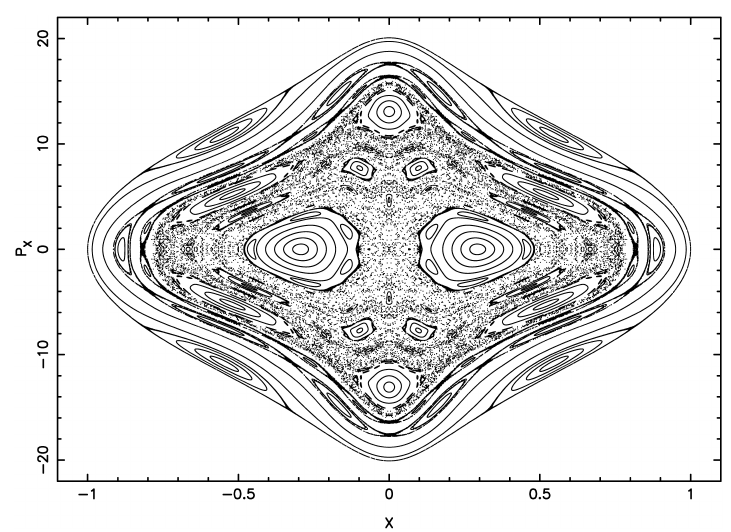
Fig. 1. The x (cid:0) p x phase plane, when h 2 = 1 : 5. Details are given in the